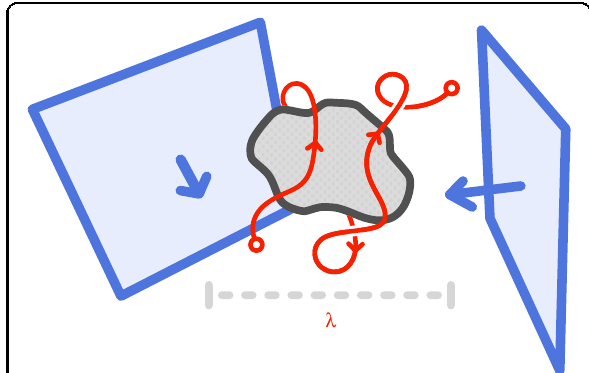
Fig. 1 The concept A cold spot moved in an arbitrary path (red line) around a nanoparticle by the changing polarisation of two plane